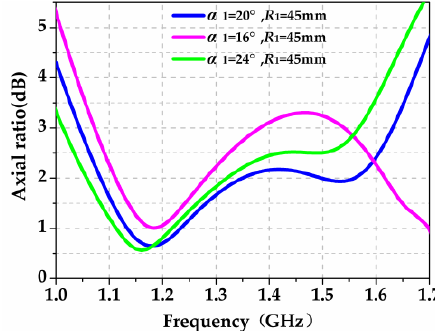
Figure 5. Simulated axial ratio (AR) versus frequency with different α 1 .